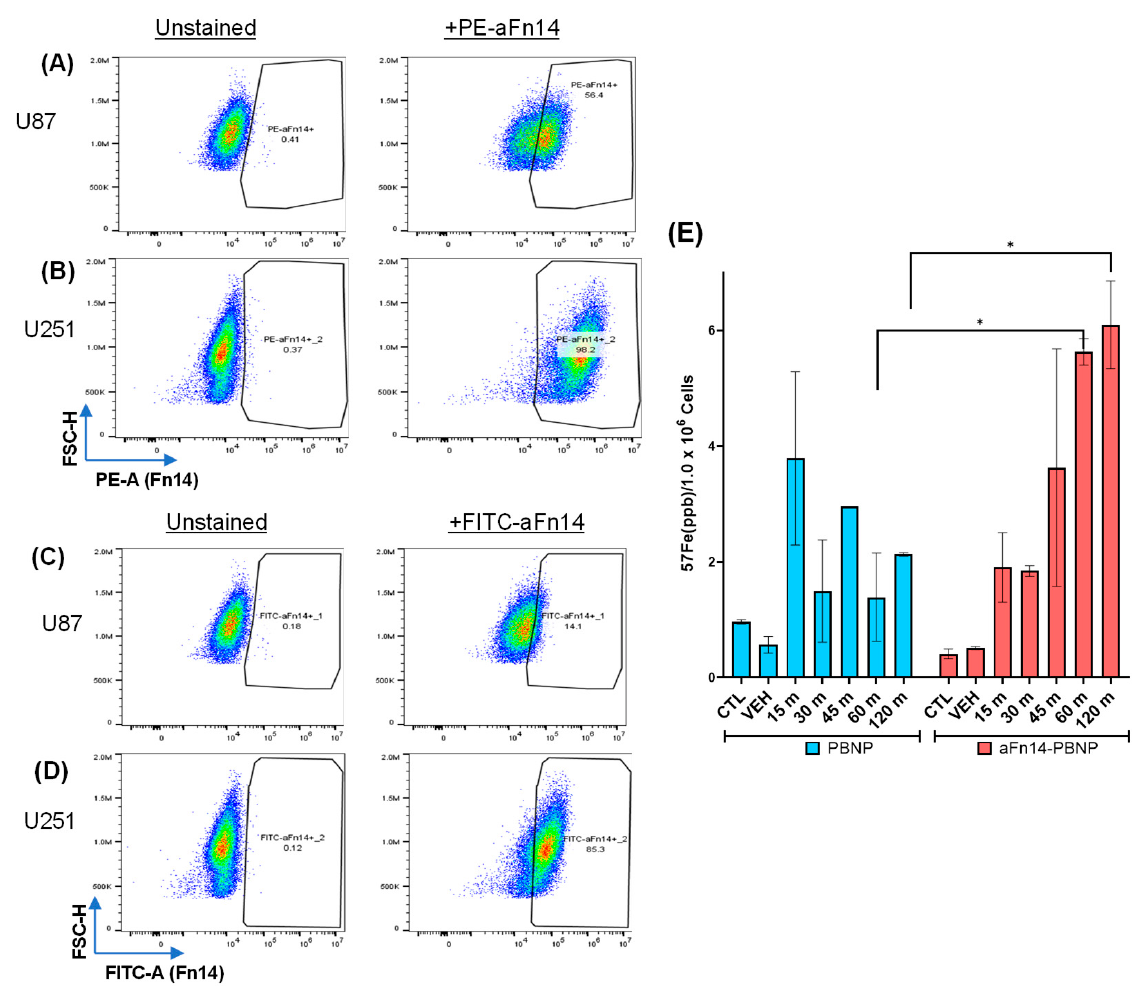
Figure 4. GBM tumor cells differentially express Fn14 that can be successfully targeted by aFn14- PBNPs. ( A , B ) Flow cytometry of ( A ) U87 and ( B ) U251 cells stained with PE-conjugated aFn14 antibody showing percent of cells expressing Fn14, compared to unstained. ( C , D ) Flow cytometry of both cell lines using the FITC-conjugated aFn-14 antibody compared to unstained. ( E ) ICP-MS of human U87 GBM cells incubated with 0.15 mg/mL PBNP (left) or aFn14-PBNP (right) for various time points, gating on the 57-Fe isotope. Each aFn14-PBNP group was compared to its respective PBNP group using a Welch’s t -test for significance. * = p < 0.05. CTL = control (U87 GBM cells alone). VEH = vehicle (U87 GBM cells with addition of water).